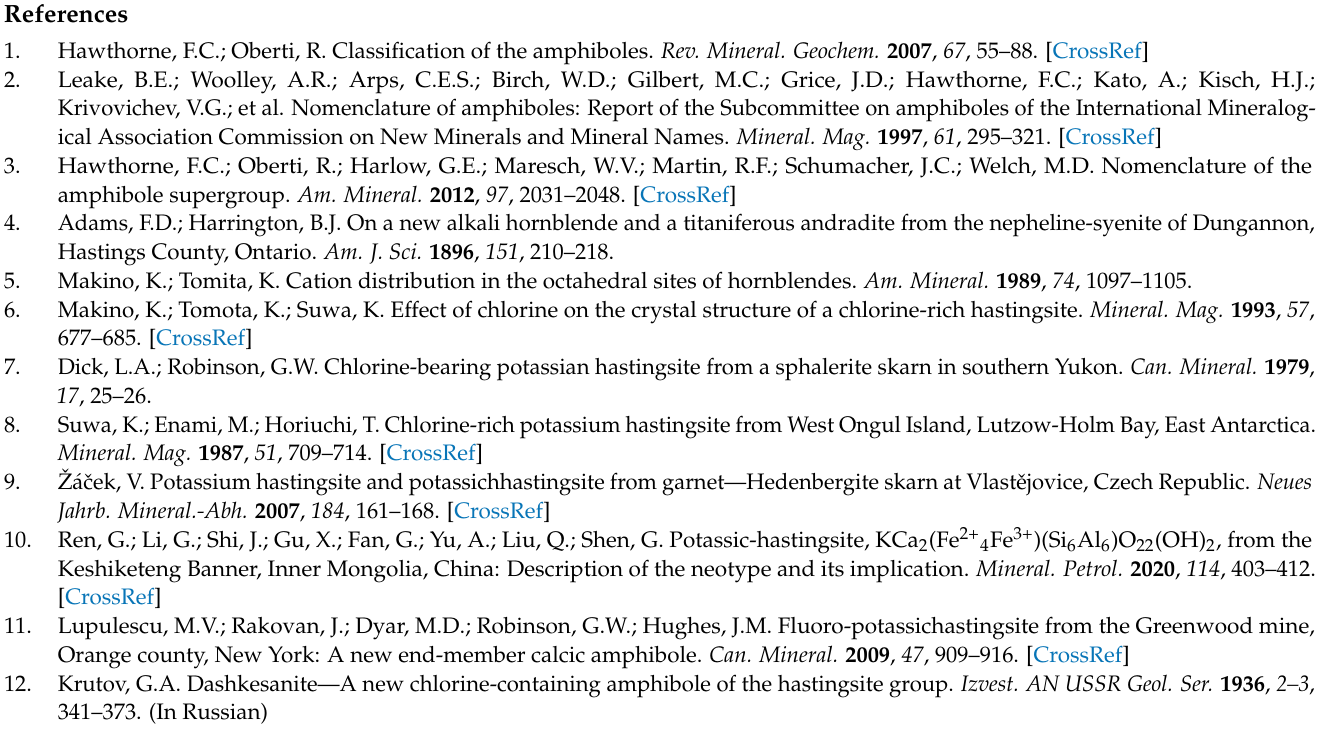
experiment, Figure S2: XRPD patterns of potassic-hastingsite showing the evolution of the diffraction patterns collected during the cooling experiment, Figure S3: Graphical representation of the thermal expansion tensor of the potassic-hastingsite at 100 ◦ C, Figure S4: Graphical representation of the thermal expansion tensor of the potassic-hastingsite at 350 ◦ C, Figure S5: Graphical representation of the thermal expansion tensor of the potassic-hastingsite at 400 ◦ C, Figure S6: Graphical represen- tation of the thermal expansion tensor of the potassic-hastingsite at 600 ◦ C, Figure S7: Graphical representation of the thermal expansion tensor of the potassic-hastingsite at 750 ◦